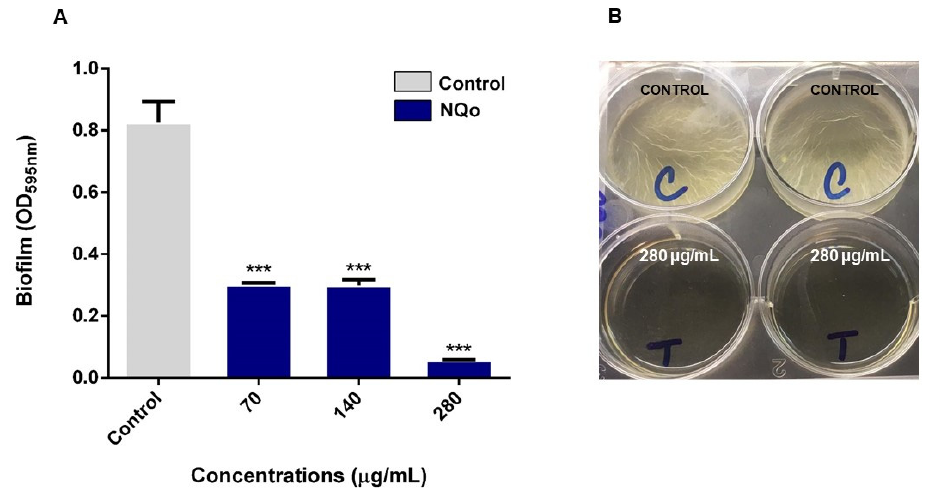
Figure 4. E ff ect of MIC NQo on Pseudomonas sp. biofilm formation at room temperature (25 ◦ C): ( A ) quantification of biofilm formation; ( B ) control and NQo MIC treatment (280 µ g / mL) wells. Figure 4. Effect of MIC NQo on Pseudomonas sp . biofilm formation at room temperature (25 °C): ( A ) *** p < 0.001 indicates statistical significance as compared to the quantification of biofilm formation; ( B ) control and NQo MIC treatment (280 μ g/mL) wells. *** p < 0.001 indicates statistical significance as compared to the control.